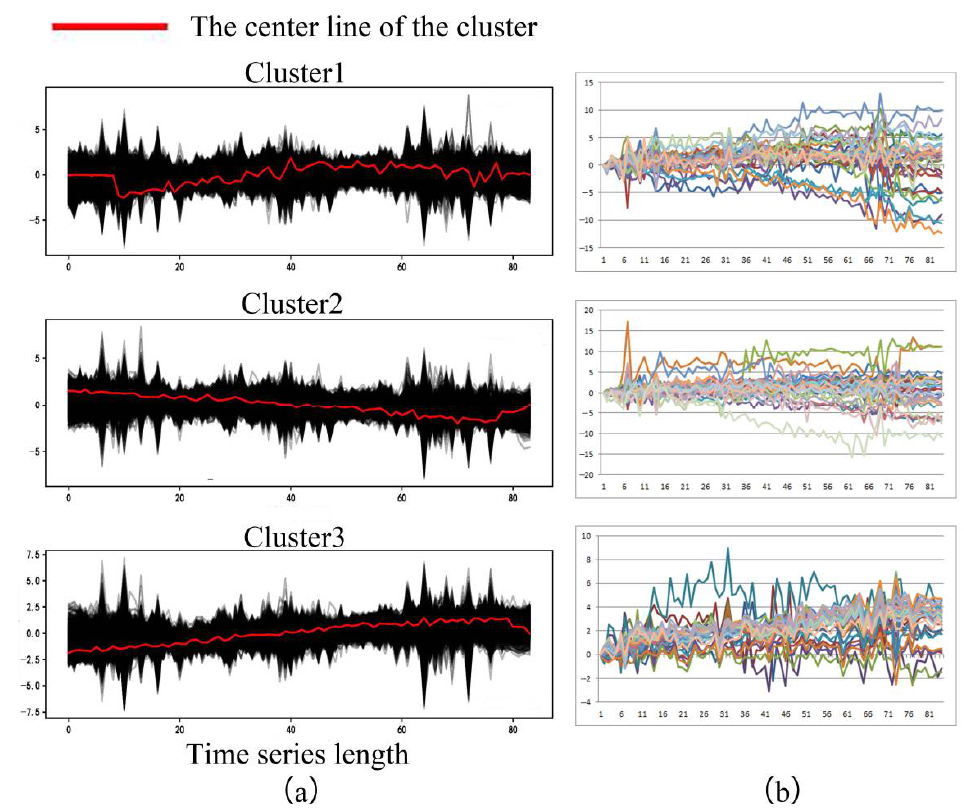
Figure 9. K-shape clustering results (( a ) is the result of clustering the cumulative deformation rate of the time series in the study area using the K-shape time clustering algorithm; ( b ) presents the extraction of 30 records from three categories to draw a subsidence time-series diagram).